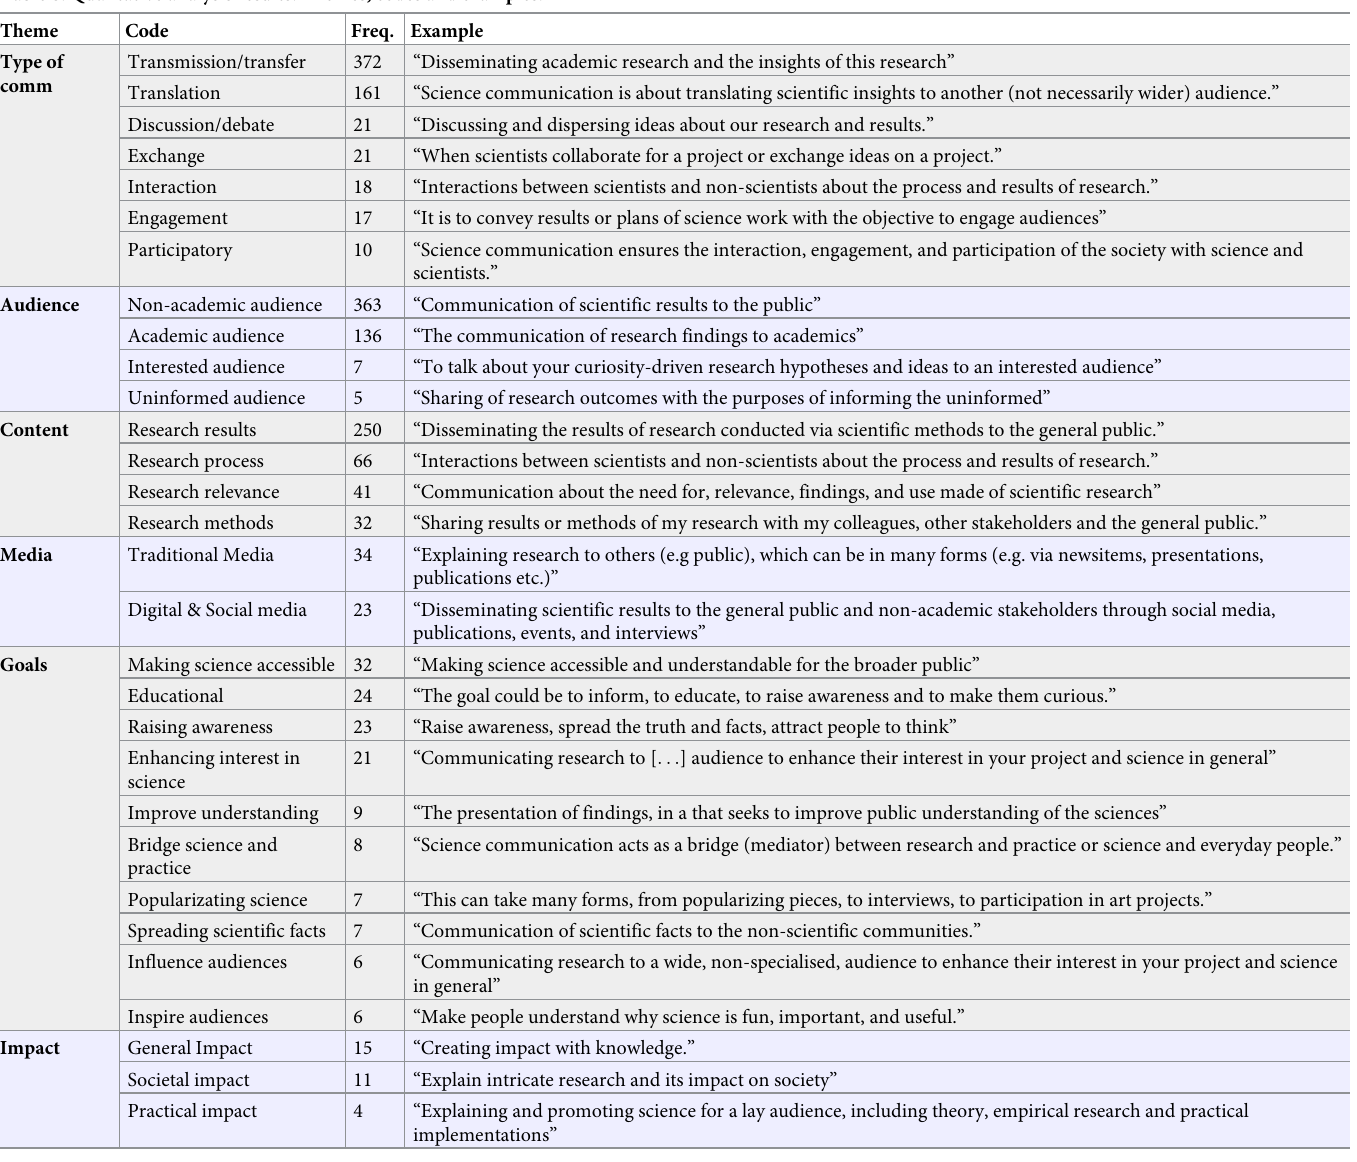
Table 8. Qualitative analysis results: Themes, codes and